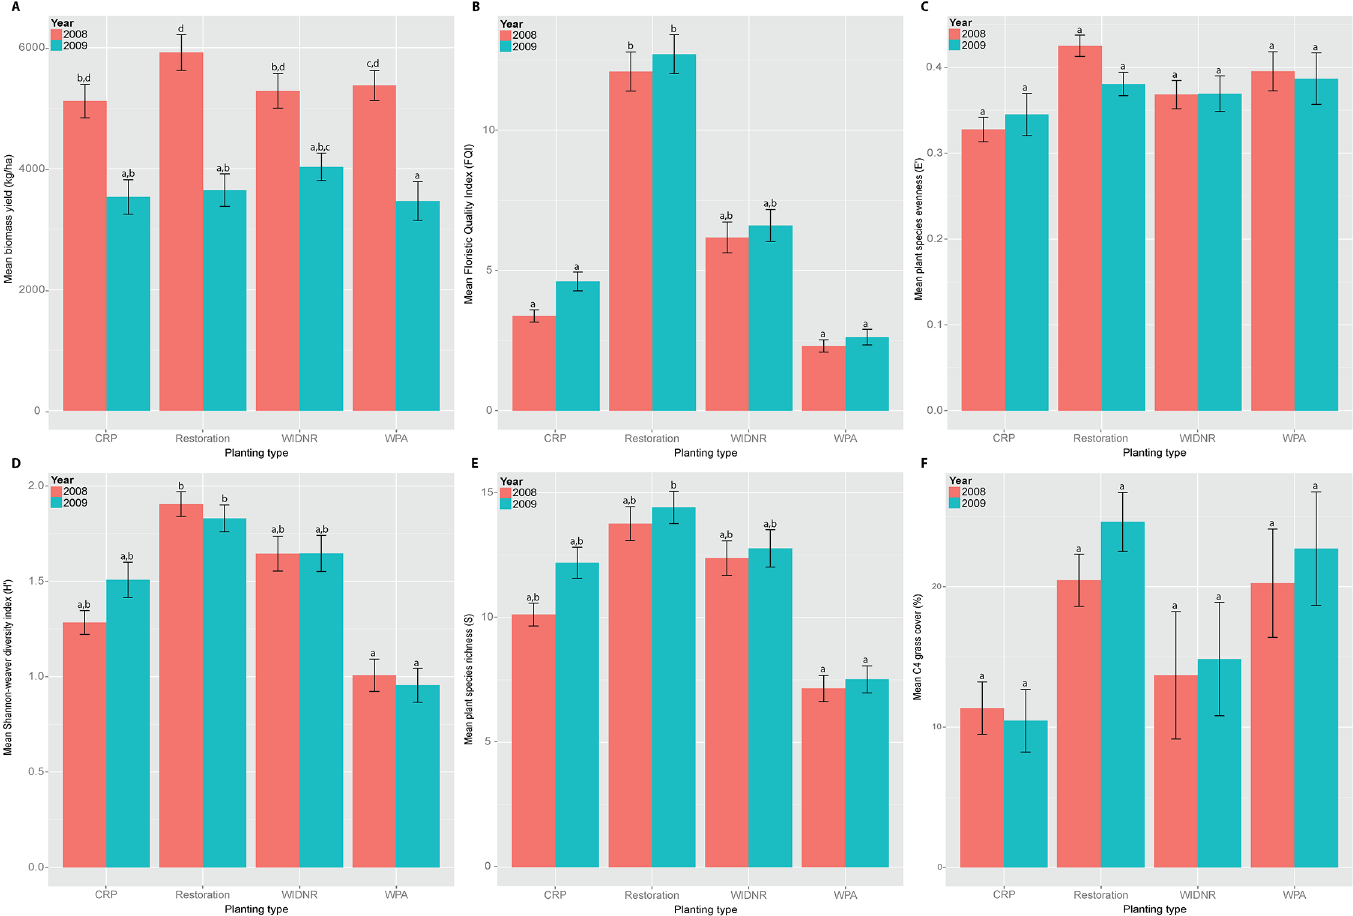
Fig 2. Box plots of vegetation characteristics by planting type and year. Letters indicate means that are significantly different (Tukey ’ s HSD, P < 0.05) for (A) biomass yield (kg/ha), (B) Floristic Quality Index (FQI), (C) Evenness (E 0 ), (D) Shannon-Weaver Diversity Index (H 0 ), (E) species richness (S), and (F) C4 grass cover among planting types and between